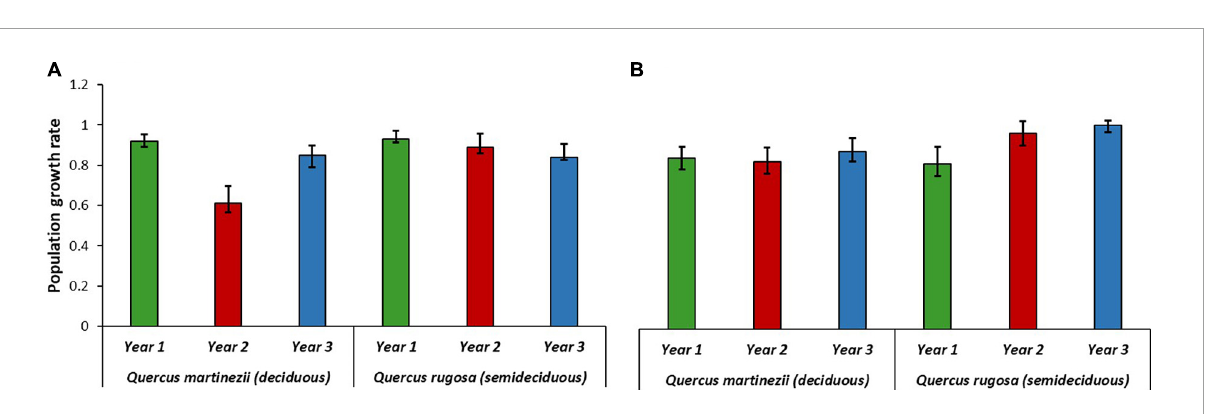
FIGURE4 Population growth rates ( λ values) of (A) Alamania punicea and (B) Oncidium brachyandrum growing on two Quercus species, from 2018 to 2020 in an oak forest in Oaxaca, Mexico. Error bars represent 95% confidence